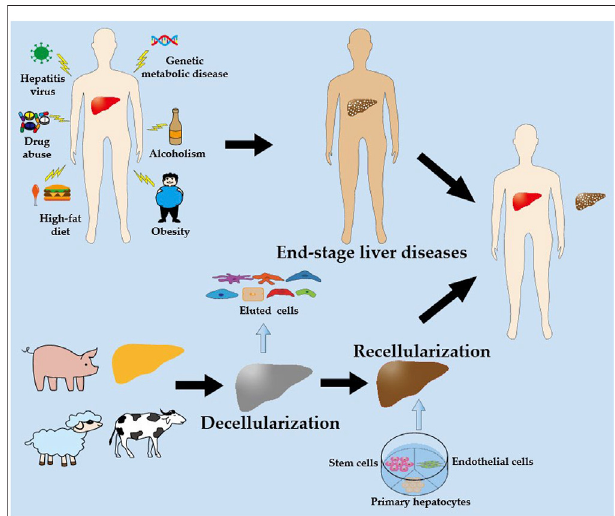
FIGURE 1 | A schematic illustration of the liver engineering based on decellularized scaffold. Livers obtained from xenogeneic animals (such as pigs, sheep and cattle) and discarded human livers are decellularized to produce decellularized scaffolds. The decellularized scaffolds are then recellularized with hepatocytes, endothelial cells, and stem cells, which are perfused in vitro to obtain a new liver. Ultimately, the new liver is transplanted into the patient with end-stage liver disease to replace the original decompensated